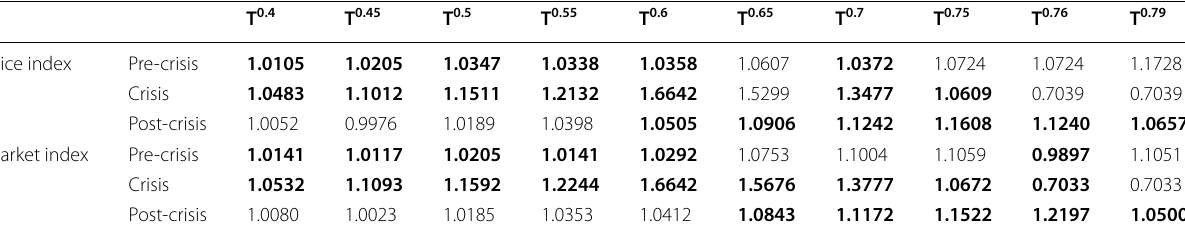
w and T are the bandwidth number and the total number of observations, respectively. For pre-crisis period, values in bold are those cases where the d estimates are not significantly different from 1, while for post-crisis period, values in bold are those cases where the d estimates are significantly higher than 1